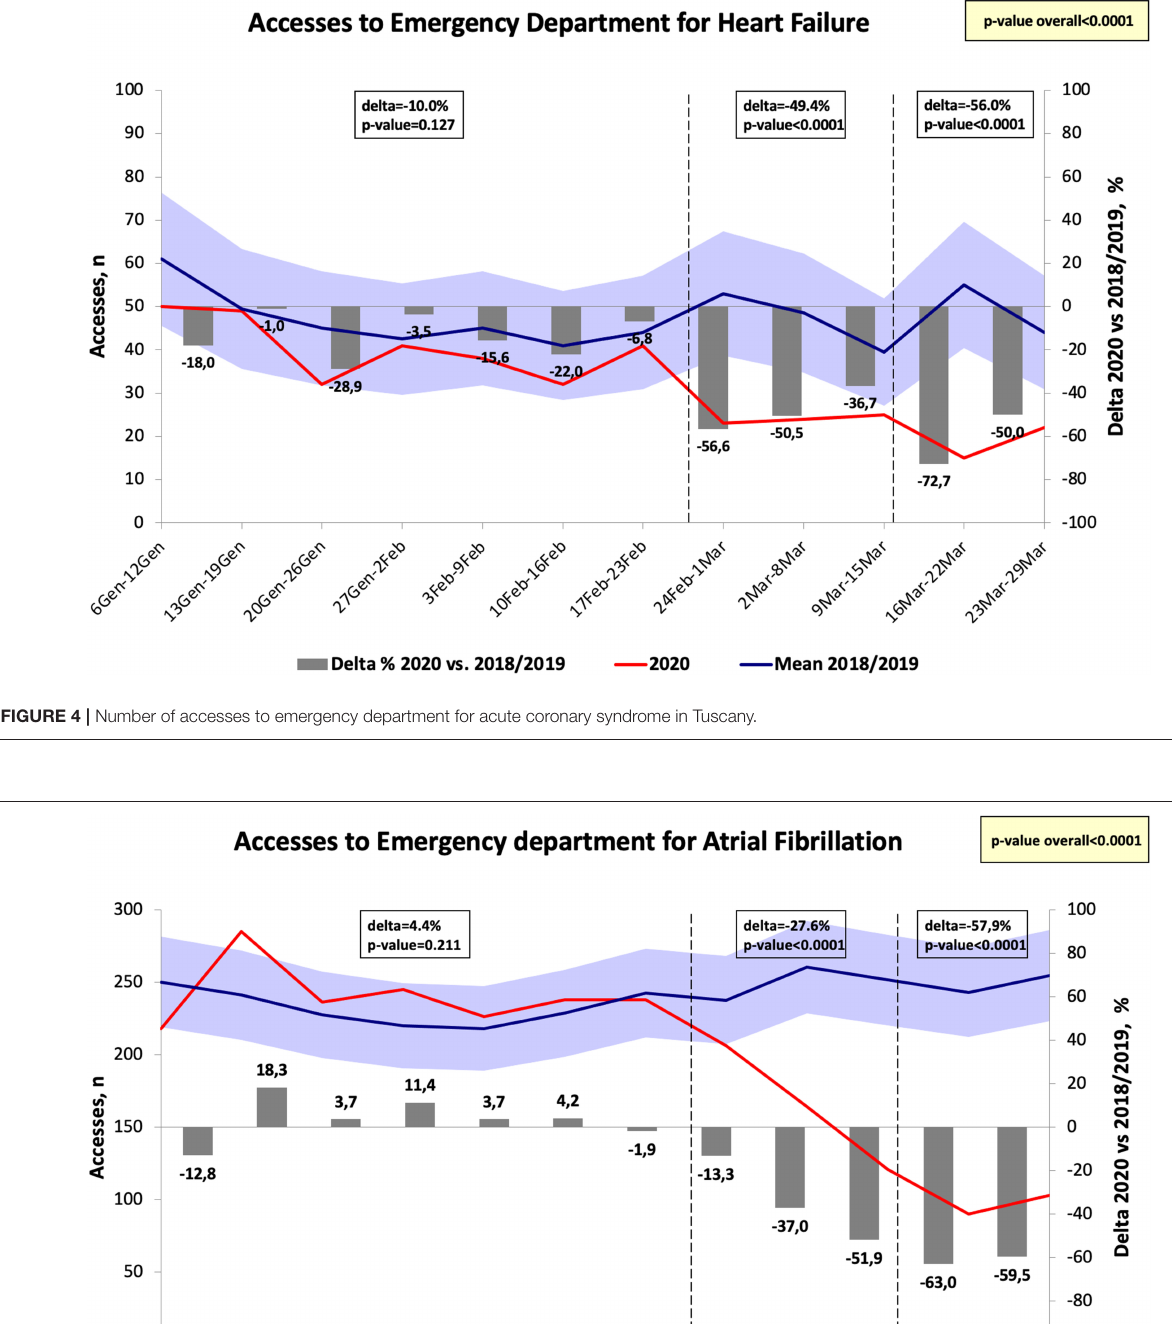
Frontiers in Cardiovascular Medicine | www.frontiersin.org